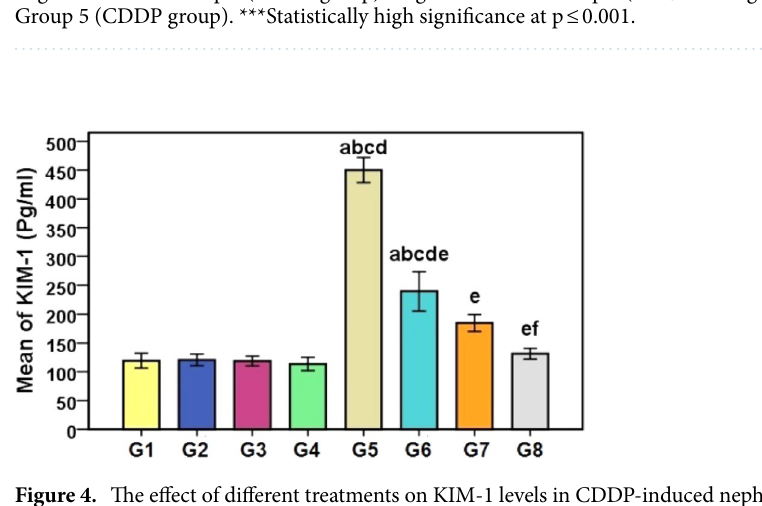
Figure 4. The effect of different treatments on KIM-1 levels in CDDP-induced nephrotoxicity in all the studied groups. Values are means ± SE ( n = 8). Data were analyzed by a one-way ANOVA test followed by Tukey’s post hoc test for multiple comparisons. a p < 0.001 versus control group (G1), b p < 0.001 vs. GA (G2), c p < 0.001 vs. CMCS group (G3), d p < 0.001 vs. GA@CMCS group (G4). e p < 0.001 versus the CDDP group (G5), f p < 0.001 versus the (CDDP + GA) group